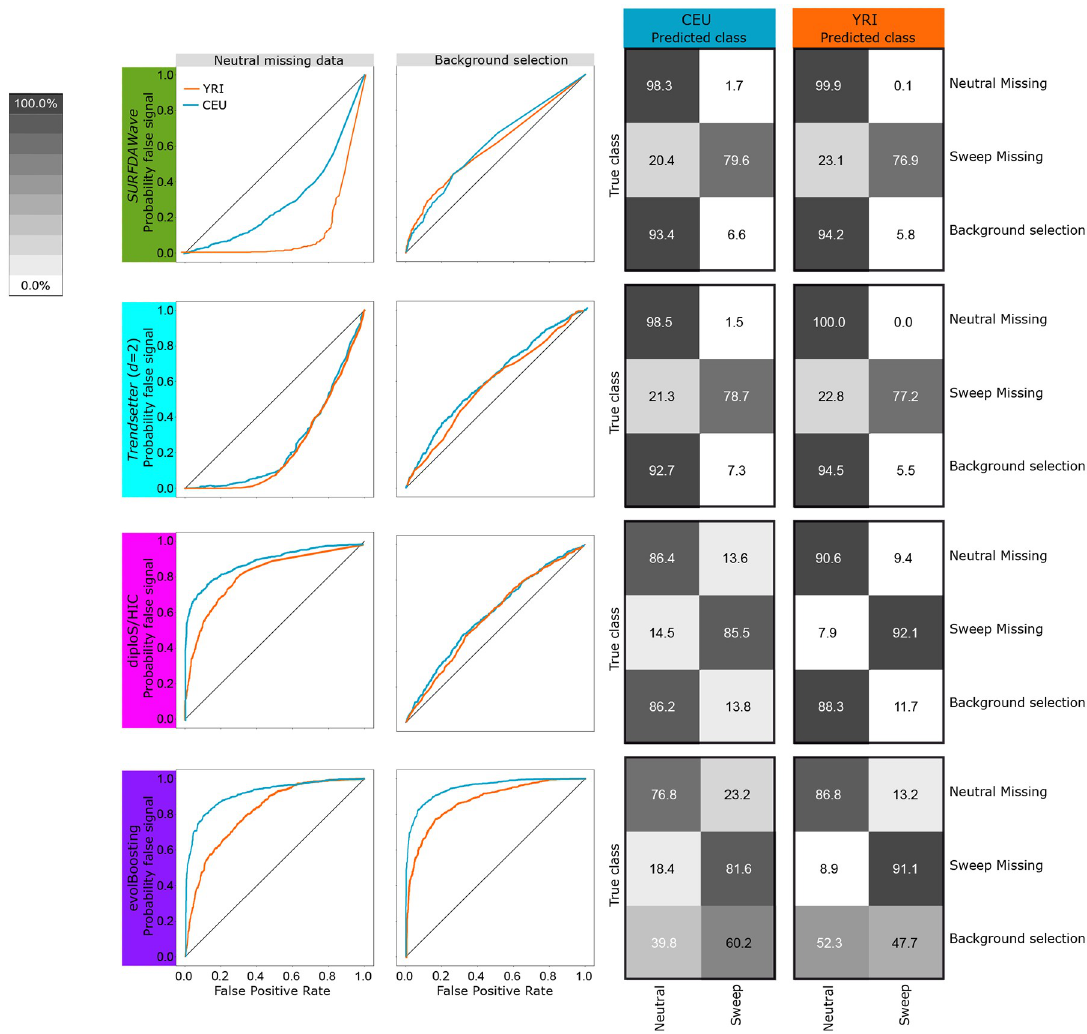
Fig 6. Comparison of method performance under confounding factors (missing data and background selection) when trained with either CEU or YRI demographic histories when SURFDAWave , Trendsetter , diploS/HIC, and evolBoosting are trained to differentiate between sweeps and neutrality. (Left column) Probability of mis-classifying neutrally-evolving genomic regions missing data as a sweep. Comparing probability of sweep in simulations missing data (probability of false signal) with the probability of any sweep in neutral simulations (false positive rate). (Left middle column) Probability of mis-classifying background selection simulations as sweep. Comparing the probability of a sweep in simulations of background selection (probability of false signal) with probability of sweep in neutral simulations (false positive rate). (Right columns) Confusion matrices showing classification rates when classifying simulations of each class with missing data, and when classifying background selection simulations. Results for both CEU (Right middle column) and YRI (Right column) demographic history. SURFDAWave is trained using Daubechies’ least-Asymmetric wavelets. Optimal γ and and level were chosen through cross validation (see Training the models ). Summary statistics ^ p , H 1 , H 12 , H 2 / H 1 , and frequency of the first, second, third, fourth, and fifth most common haplotypes used by both Trendsetter and SURFDAWave